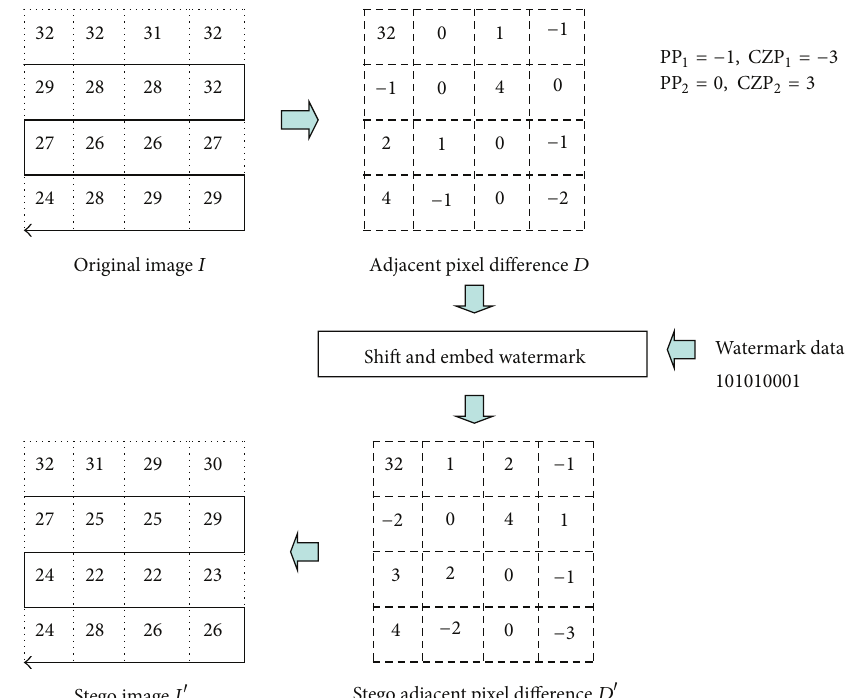
Figure 1: Example of watermark embedding of Li et al.’s APD scheme [22].